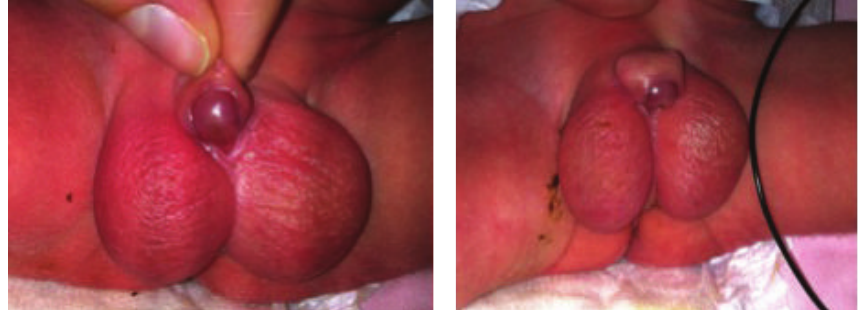
Figure 4: Images of the external genitalia of the newborn, which confirm the third-degree hypospadias. We can see the urethral meatus located in penoscrotal union, a bifid scrotum, and a curved penis with a foreskin forming a dorsal cap and a cleft ventral glans.